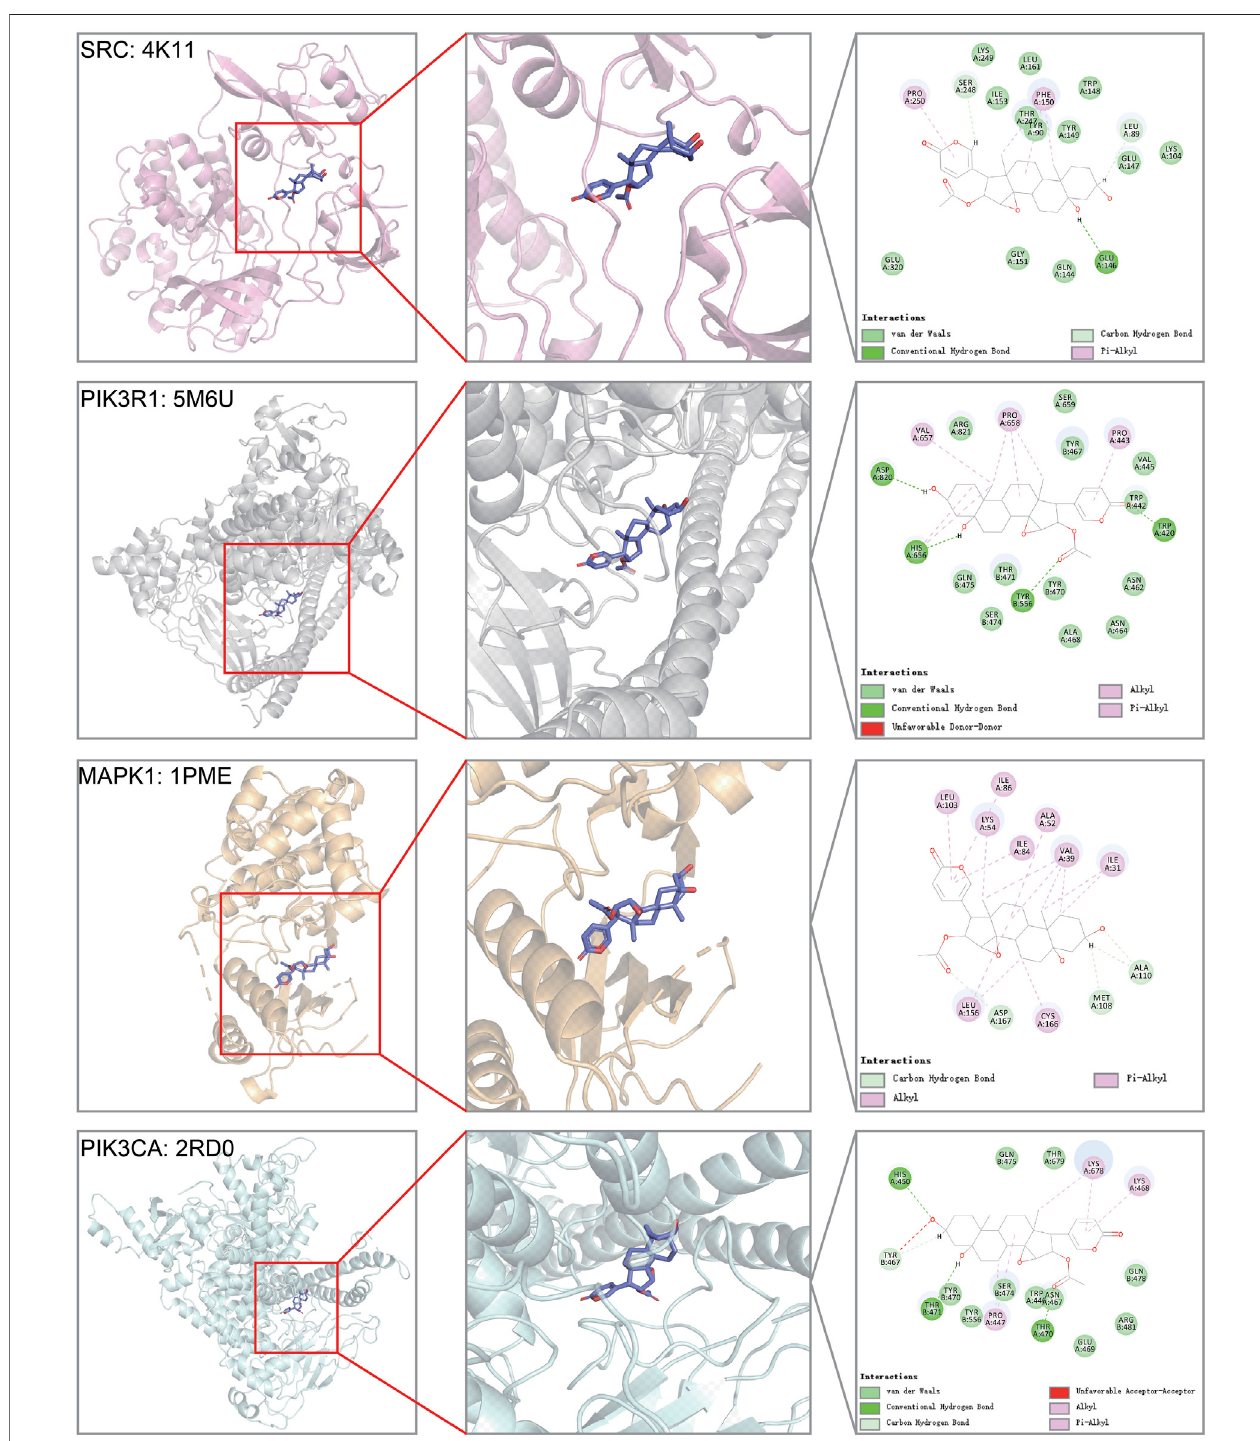
FIGURE6| Molecularmodelsofcinobufotalinbindingtopredictedproteintargets.Proteins(SRC=4K11,PIK3R1=5M6U,MAPK1=1PME,andPIK3CA=2RD0) interact with a cinobufotalin molecule, and different proteins are distinguished by different colors.